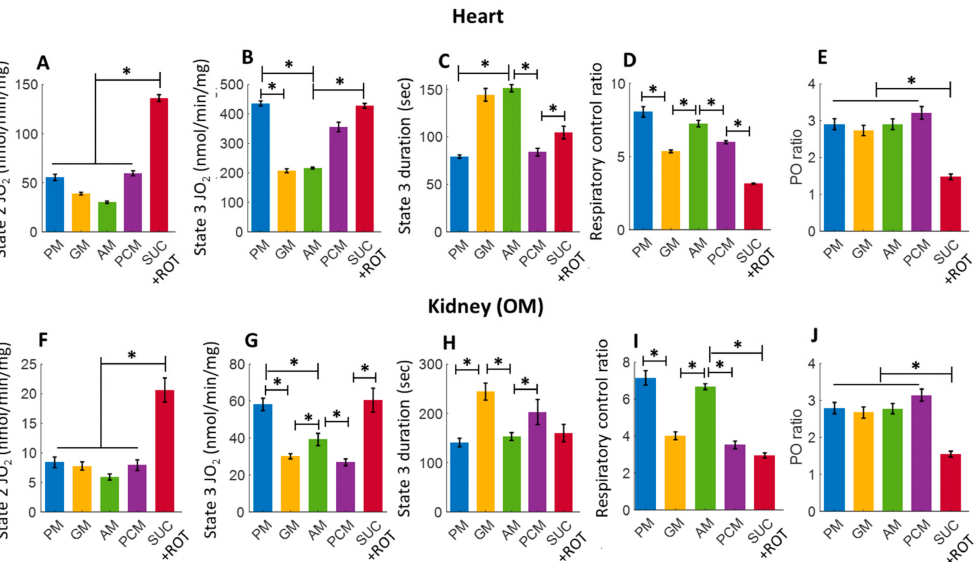
Figure 3. Summary of the different substrate-dependent respiratory parameters derived from the mitochondrial O 2 consumption rates (OCR; JO 2 ) of Figure 2 before adding CaCl 2 (CaCl 2 = 0) for the heart (upper panel; ( A – E ) and kidney OM (lower panel; ( F – J ). ( A , F ) State 2 JO 2 ; ( B , G ) State 3 JO 2 ; ( C , H ) State 3 duration of JO 2 ; ( D , I ) Respiratory control ratio (RCR; state 3/state 2 JO 2 ); and ( E , J ) PO ratio (ratio of ADP consumed to O 2 consumed). Each bar plot represents the mean value ± SEM ( n = 4–6). The symbol ‘*’ shows the statistical significance ( p < 0.05) based on one-way ANOVA with repeated